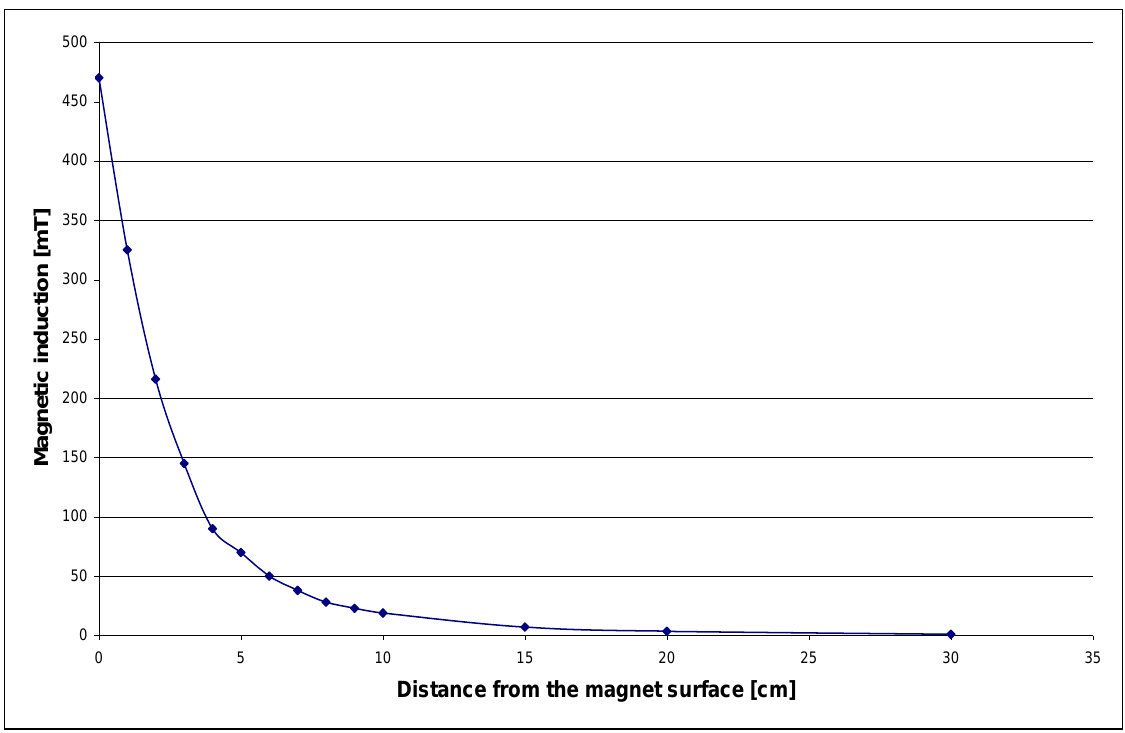
Figure 1. Characteristics of the neodymium magnet used for MEP